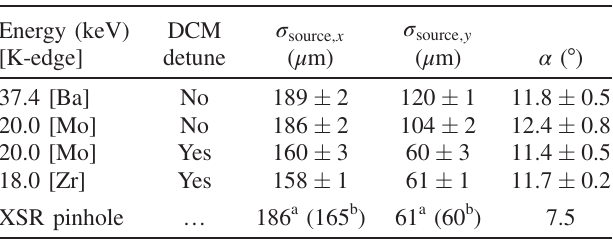
TABLE I. Extracted source sizes and tilt angles from pinhole imaging measurements at different